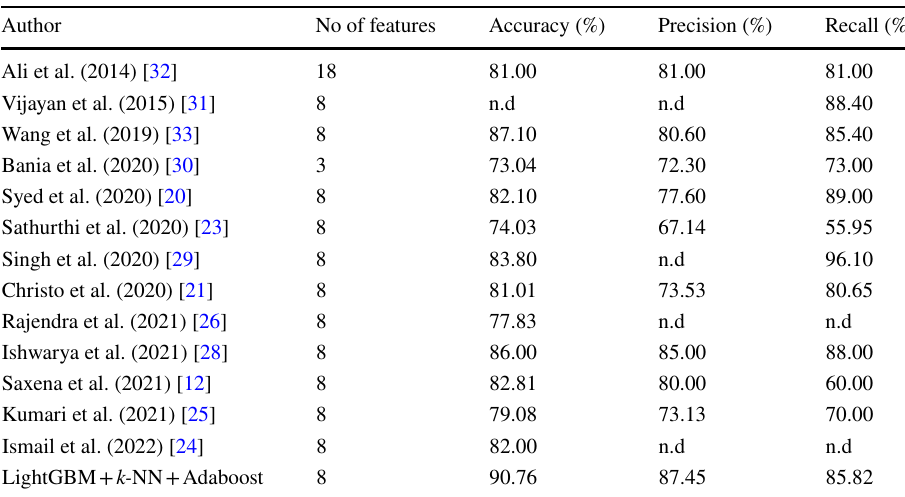
Table 11 Comparison of the proposed ensemble model with existing ensembles